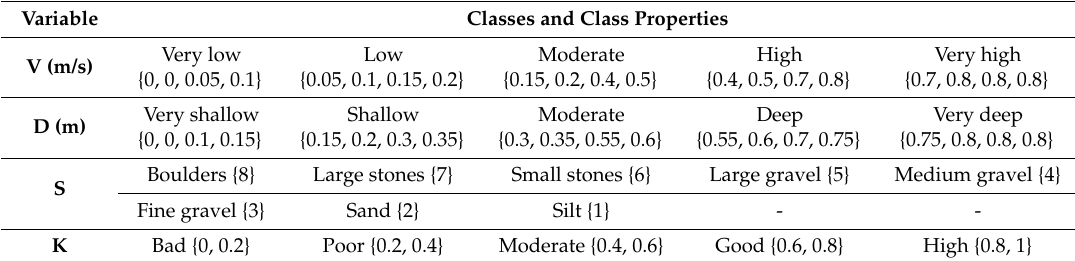
Table 1. Class names and relevant class parameters of the hydraulic variables. Substrate type (S) and habitat suitability (K) were treated as crisp (not fuzzy) sets. V: flow velocity; D: water